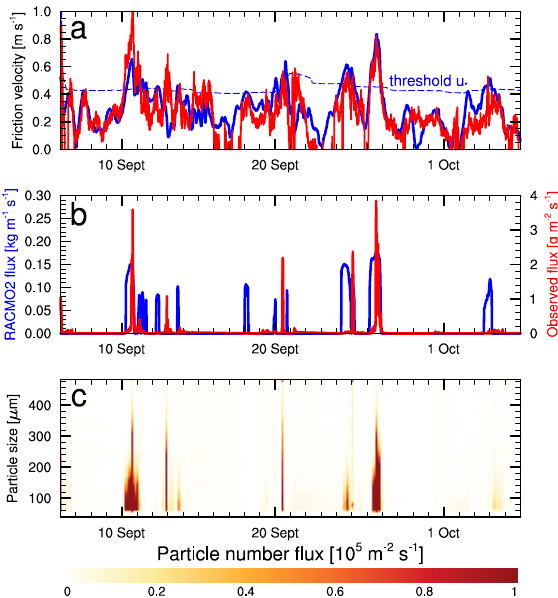
Fig. 6. Time evolution of (a) observed (red) and simulated friction velocity (blue), and threshold friction velocity for drifting snow in RACMO2 (dashed) blue); (b) observed (red) and simulated (blue) drifting snow transport, with the observations originating from 1 level only, whereas RACMO2 snow transport is vertically integrated (mind the different units); and (c) observed number of snow parti- cles per particle size.